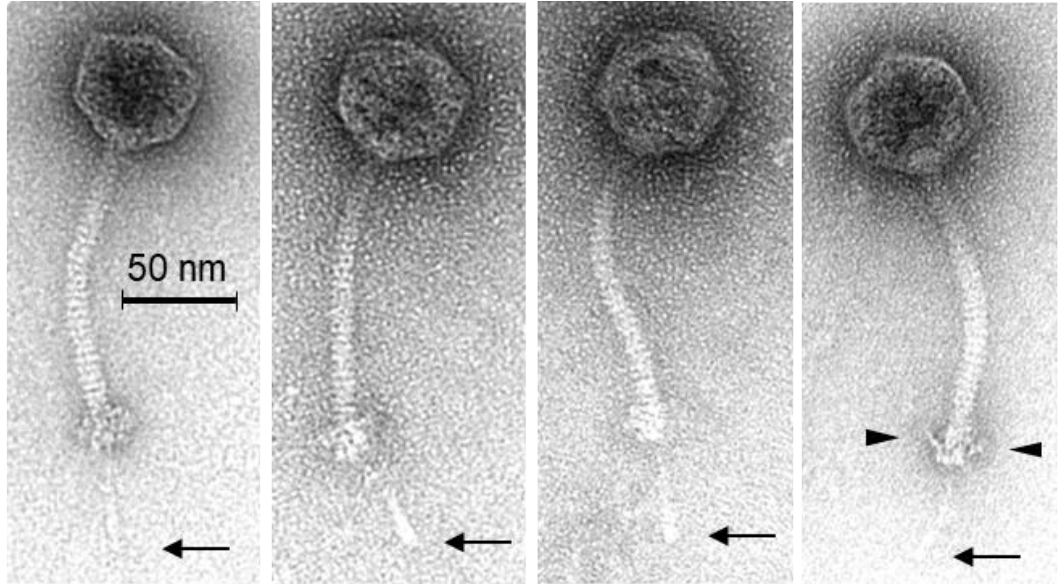
Figure 1. Transmission electron micrographs of Eggerthella lenta phage PMBT5 stained with 1% ( w / v ) uranyl acetate. The thin arrows indicate the central tail fiber under the baseplates with typical cylindrical extension at the distal end. The triangles show protruding baseplate appendages in upwards folded position.